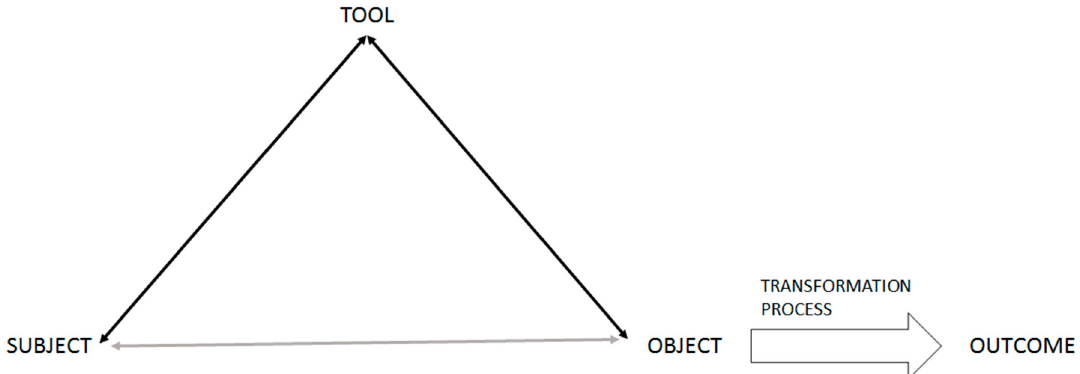
Figure 1. Activity Theory model at individual level (adapted from [17]).